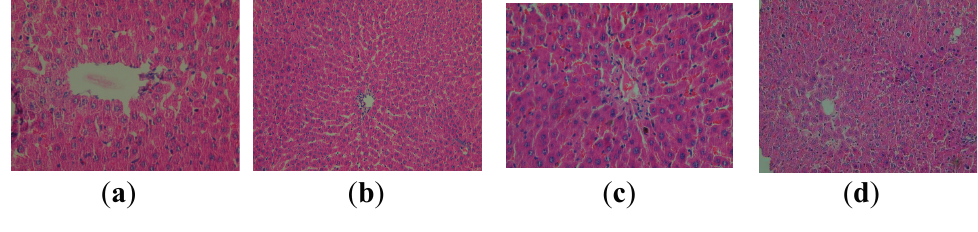
Figure 3. Histopathological evaluation of the liver tissue for the treated groups: ( a ) group V (group CCl4-apitherapy diet) Isolated vesicular steatosis (HEx400); ( b ) Discrete inflammatory infiltrate (HEx200); ( c ) Discrete congestion (HEx400); group VI (group CCl4-apitherapy diet + RJ) ( d ) Discrete inflammatory infiltrate (HEx200).